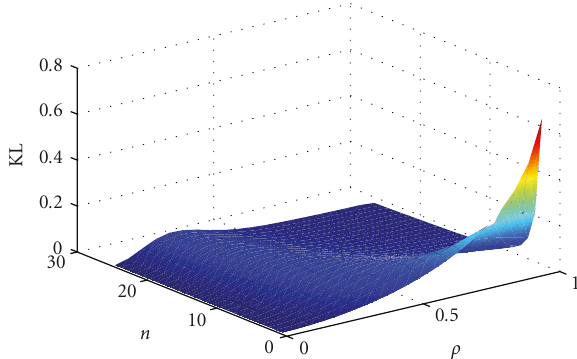
Figure 1: Kullback-Leibler (KL) divergence of joint PDF and product of the marginal PDF for di ff erent looks number and the coherence.